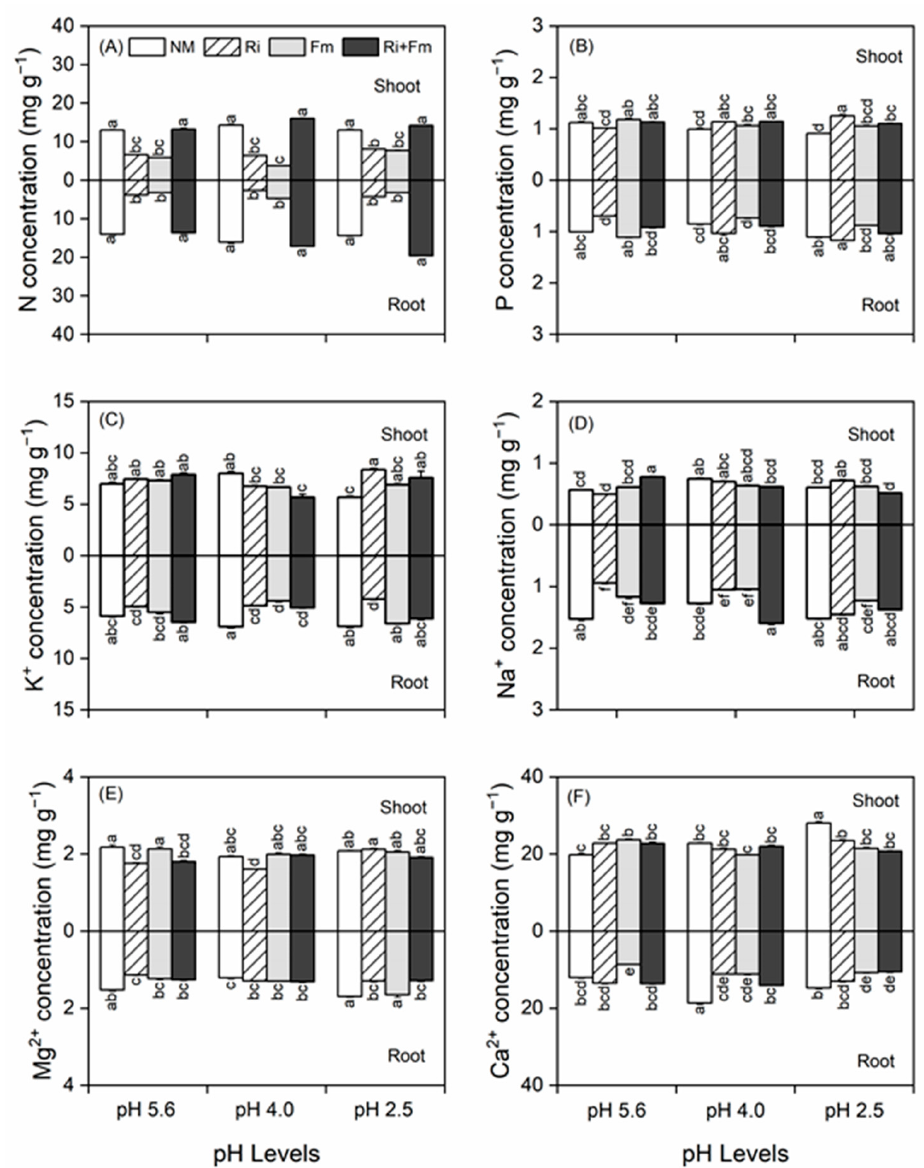
Figure 5. Effects of arbuscular mycorrhizal fungi on macronutrients of N ( A ), P ( B ), K + ( C ), Na + ( D ), Mg 2+ ( E ), and Ca 2+ ( F ) in shoot and root of Torreya grandis under acid rain with pH 5.6, 4.0, and 2.5. NM, Ri, Fm, and Ri+Fm represent the four AMF treatments: inoculation with no mycorrhizal fungi, with Rhizophagus irregularis, with Funneliformis mosseae , and with the combination of the two fungi inoculum, respectively. Values are presented as the mean ± SE ( n = 3). Different letters indicate a significant difference ( p < 0.05).